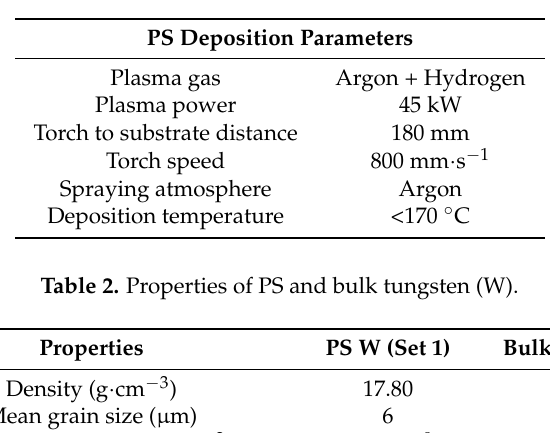
Table 1. Plasma-sprayed (PS) deposition parameters.